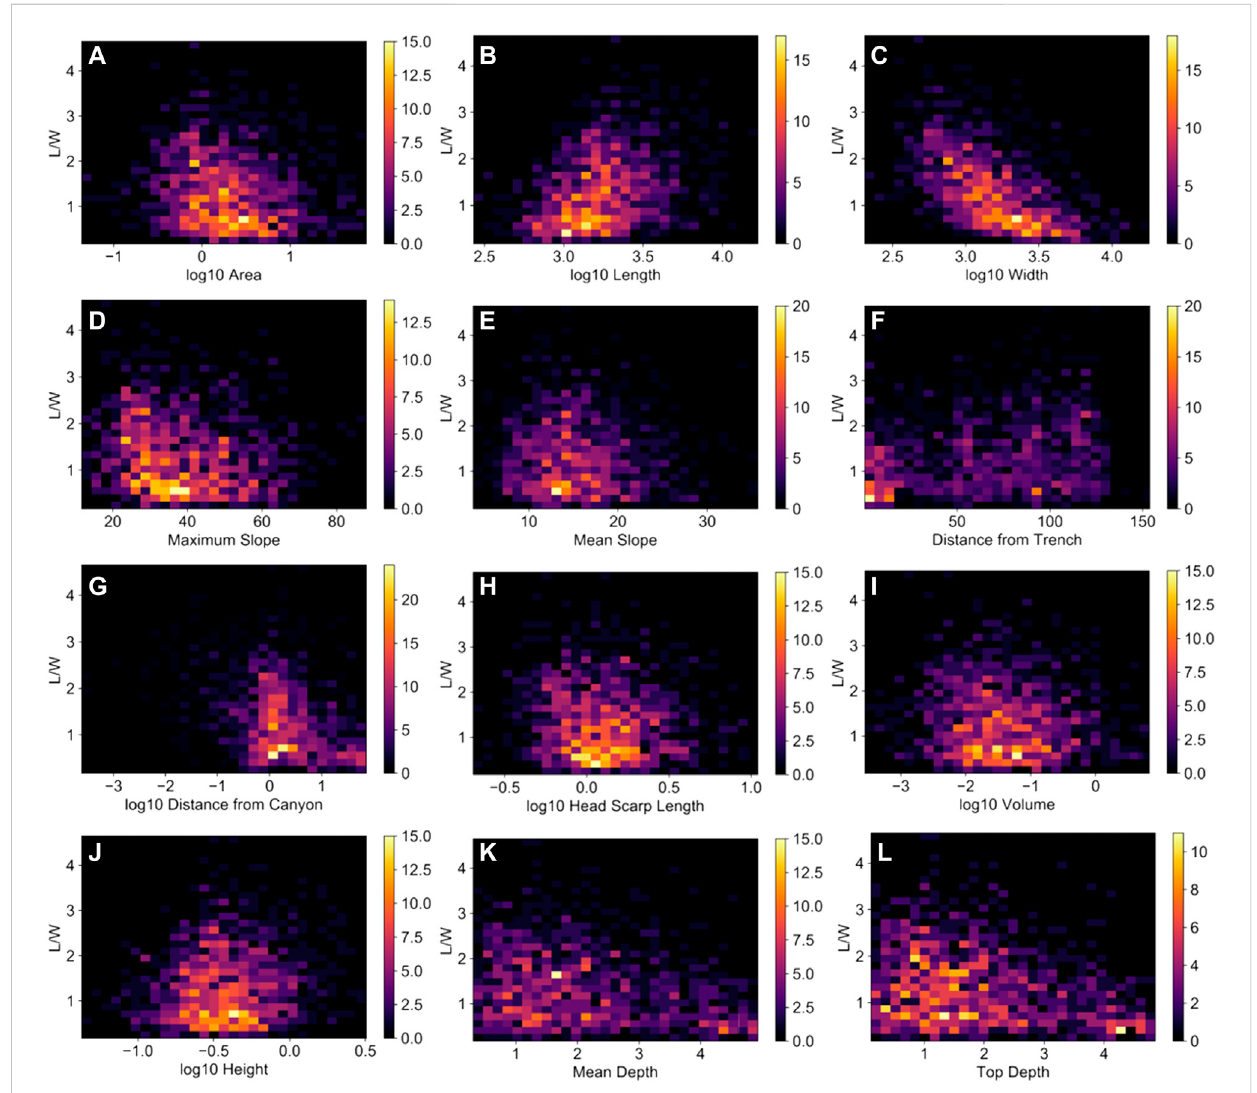
FIGURE 9 2D histograms of submarine landslide parameters with respect to the L/W (refer to Figure 7 for units). Majority of the parameters have highly scattered plots (E,F,H, I,J,K, L) , although (A) area, (C) width, (D) maximumslope,and (G) distancefromthesubmarinecanyonshow an apparent inverse trend. In addition, an apparent positive trend is observed in (B) length and